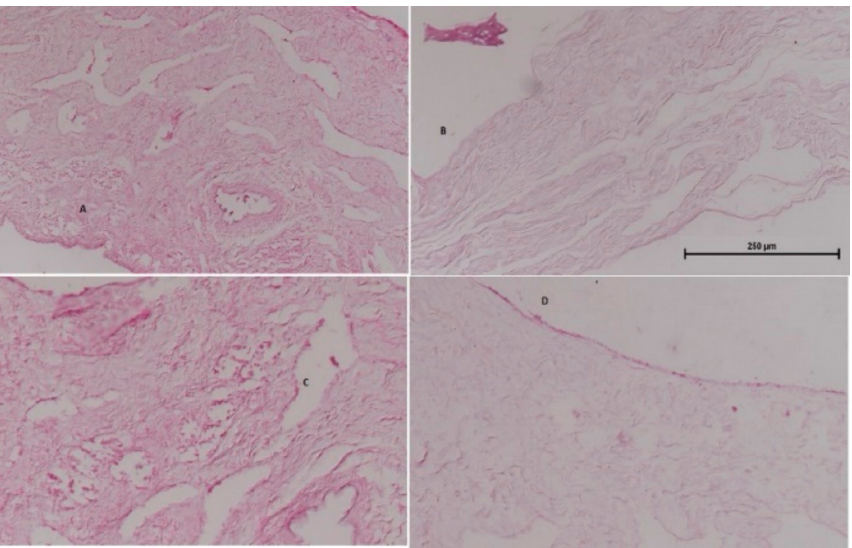
Figure 13. Represents histological sections of goat nasal mucosa using hematoxylin eosin saffron staining (scale bar 250 µ m). ( A ) normal mucosa (negative control), ( B ) mucosa treated with isopropyl alcohol (positive control treated), ( C ) mucosa treated with rotigotine solution, and ( D ) mucosa treated with rotigotine